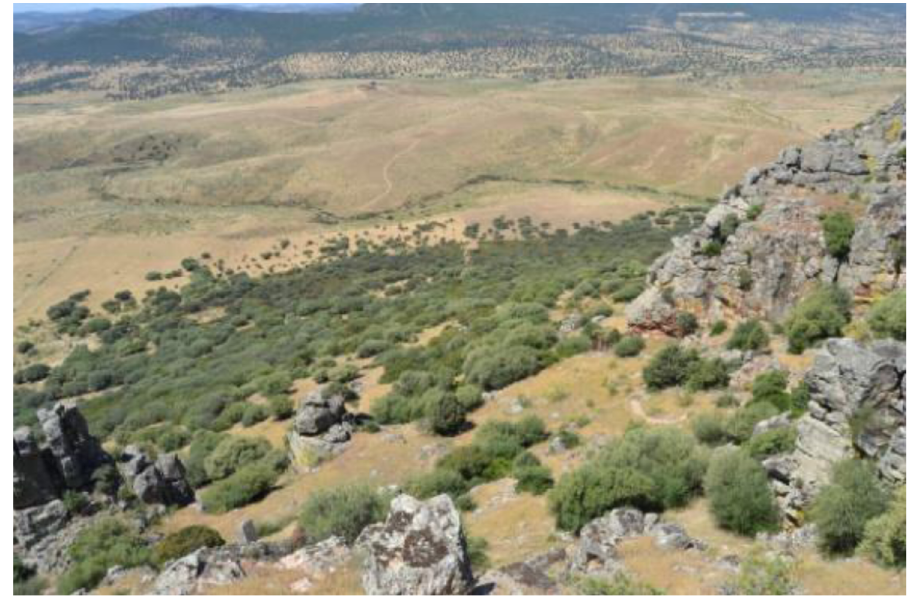
Figure 16. Asparago albi - Oleetum sylvestris .